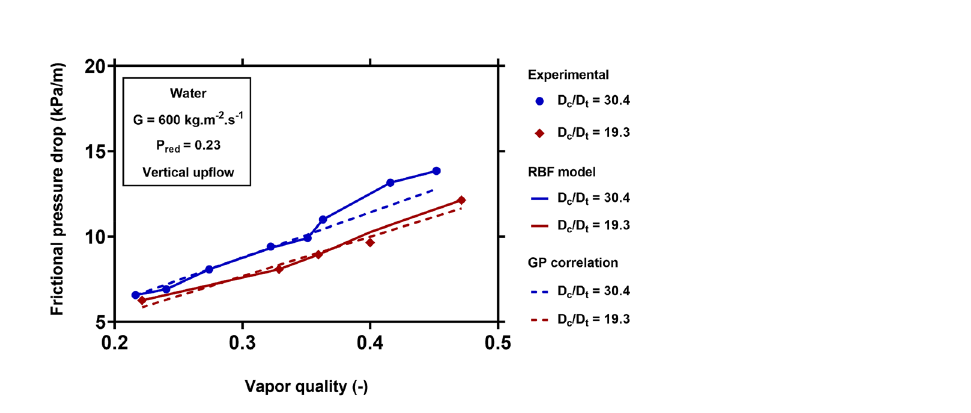
Figure 10. Effect coil to tube diameter ratio on the variation of two-phase FPD versus vapor quality. Comparisons of predictions of GP correlation (Eq. (20)) and RBF model with the corresponding experimental values 30